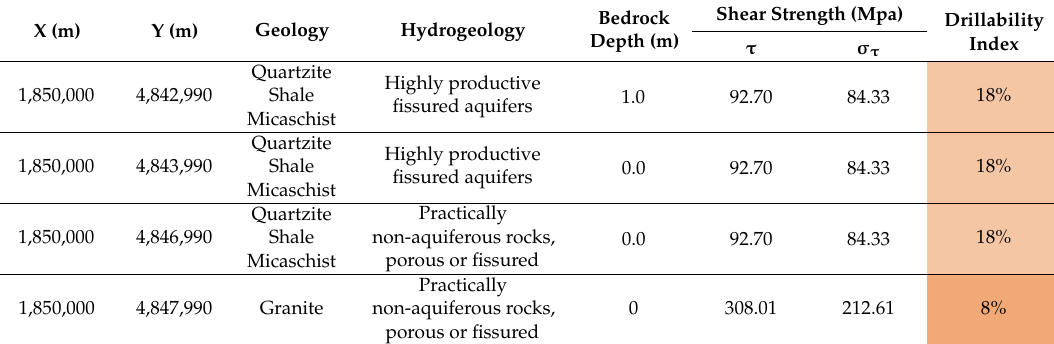
Figure 2. European grid ( Left ) with resolution of 1 × 1 km 2 ( Right ); zoom extracted from the country of Andorra. Table 9. Database to define drillability index (grid node examples located in Andorra; colours of results cells compliant with colours used in Figure 3—see online version).